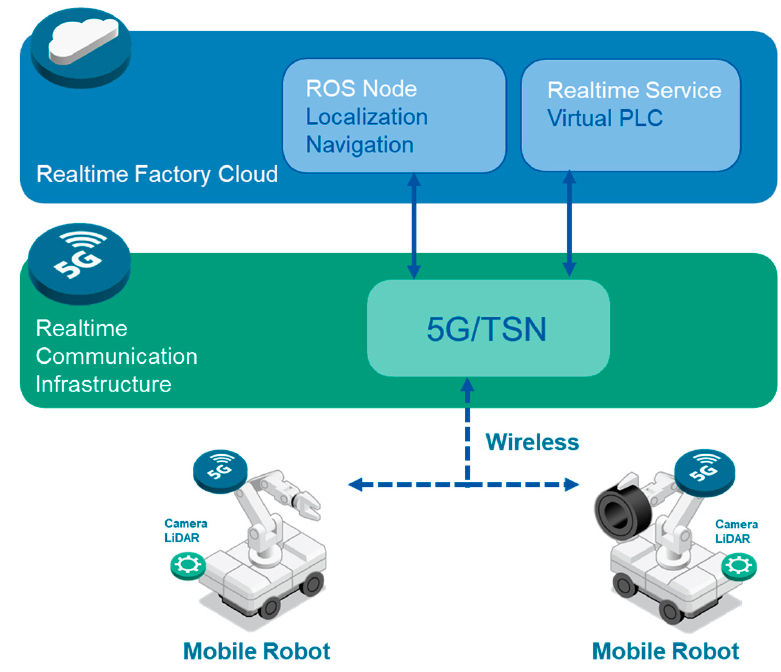
Figure 1. Architecture of a Factory Cloud-Controlled Robotics Application.